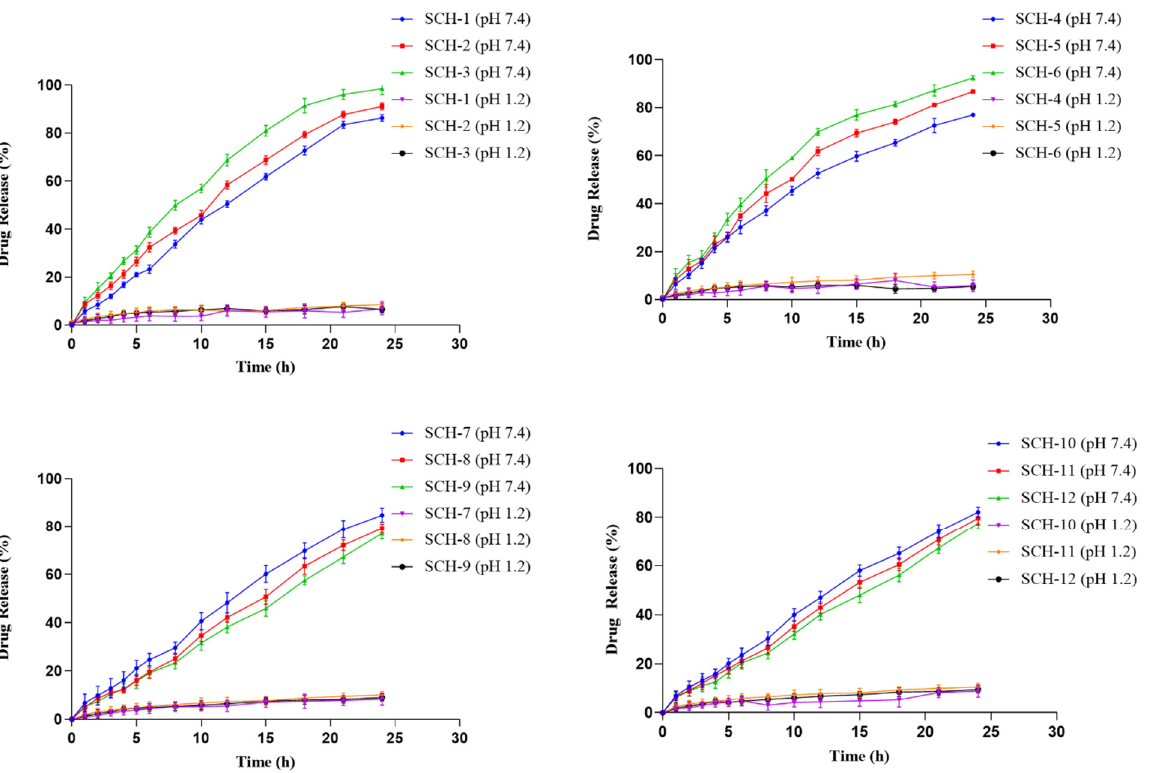
Figure 11. Effect of CP-934P, Na-Alg, MAA, and MBA on the DF release % from the developed hydrogel formulations (SCH-1 to SCH-12).